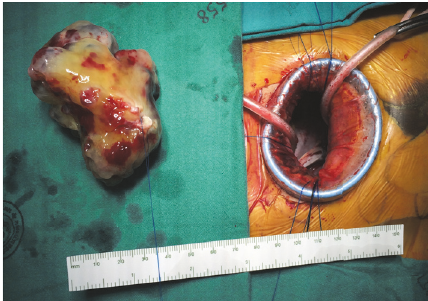
Figure 2: The large mass after removal compared to the